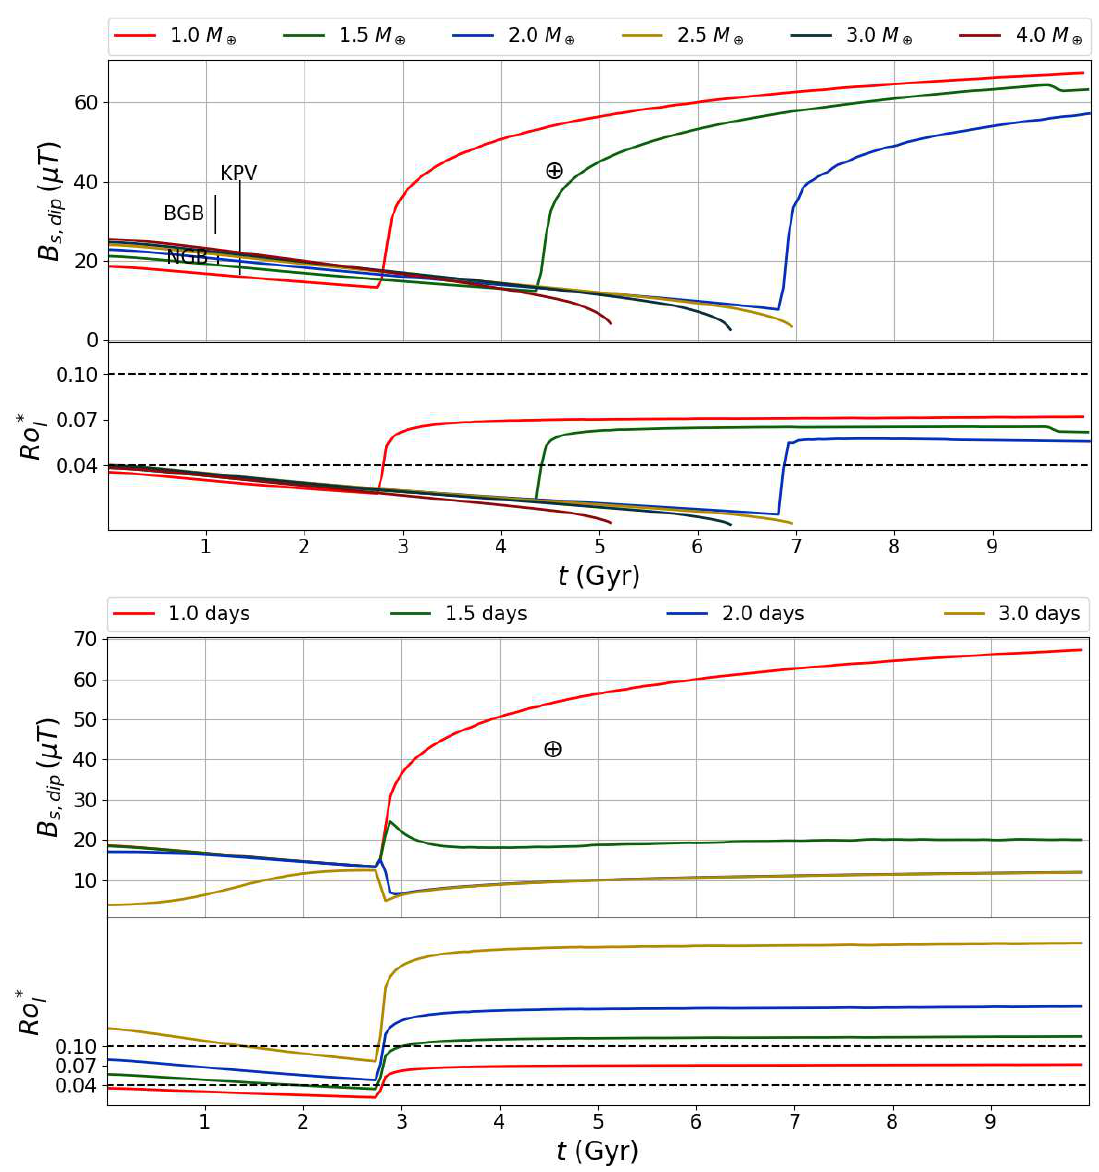
Figure 14. Maximum dipolar component of the PMF at the surface estimated using CTE. Upper panel: B s , dip for a constant rotation pe- riod=1.0 day and differet planetary masses. Lower panel: B for a constant planetary mass = 1.0 M and different rotation periods. The ⊕ s , dip value of the Ro * has also been plotted to illustrate the effect that a transition between dynamo regimes have in the evolution of the PMF. l The black dashed lines in the lower Ro * panels are the limits between the regimes (dipolar non reversing, dipolar reversing and multipolar). l The value of B for the present Earth’s and paleomagnetic measurements made at Kaap Valley (KPV), Barberton Greenstone Belt (BGB), s , dip and Nondweni Greenstone Belt (NGB), dacite localities has also been included (Tarduno et al.